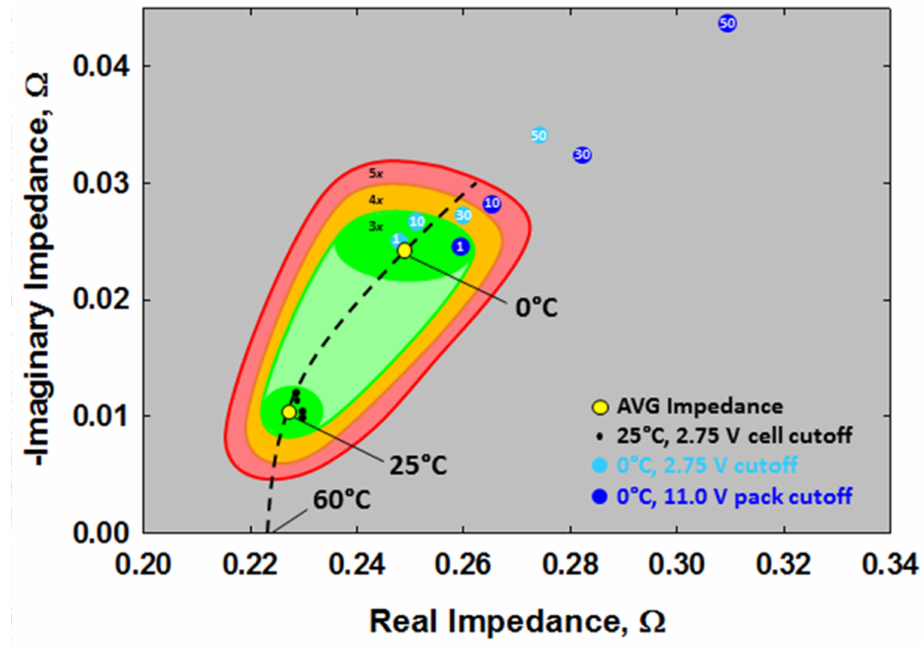
Figure 9. SOH map generated from single-point impedance responses at f SOH = 316 Hz for 4S packs cycled at 25 ◦ C, 0 ◦ C with 2.75 V cell cutoff (light blue circles) and 0 ◦ C with 11.0 V pack cutoff (dark blue circles) after 1st, 10th, 30th and 50th discharge cycles, where the cycle number is denoted inside the circles. The acceptable impedance variance range (<3 × ) is shown in green, 4 × in orange and 5 × in red. The empirical relationship between impedance response and temperature at f SOH is shown by the black dashed